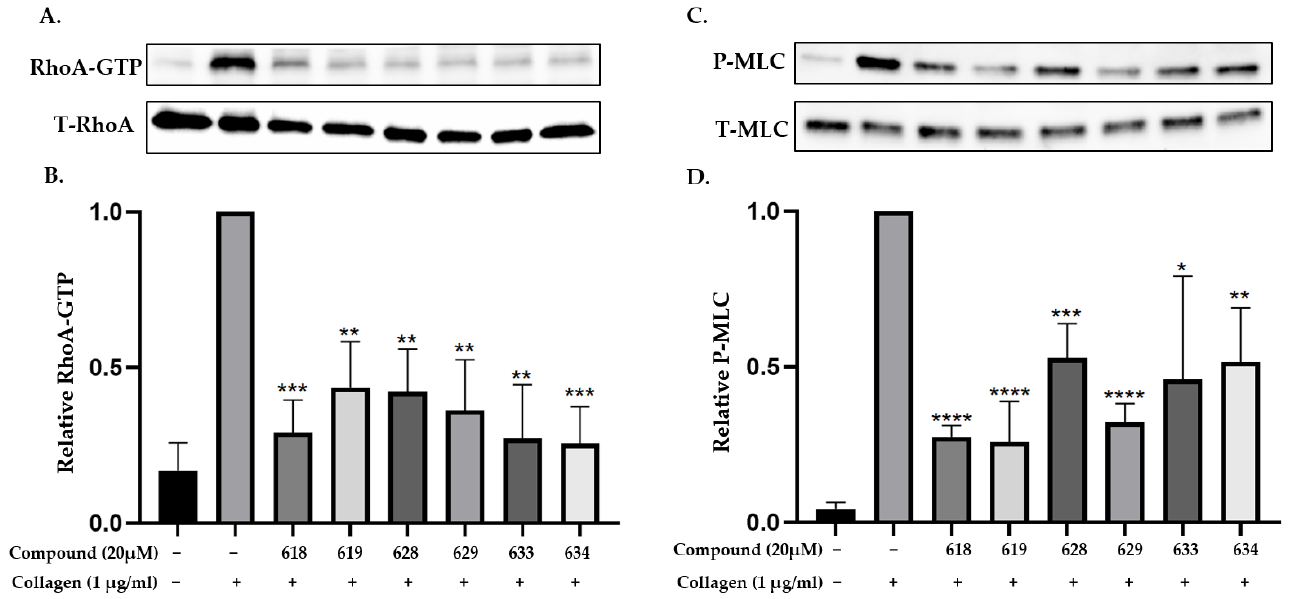
Figure 2. Active Rhosin-related compounds inhibit the activation of RhoA and phosphorylation of the myosin light chain. ( A , B ) Washed human platelets were incubated with collagen (1 µg/mL) for 4 min, and the levels of RhoA-GTP formation were quantified with a GST-Rhotekin effector pull-down assay. The platelets were pre-incubated with 20 µM UC-177618, UC-177619, UC-177628, UC-177629, UC-177633, or UC-177633 for 2 min before being stimulated with collagen. The addition of ice-cold lysis buffer terminated the reaction. The top 6 active Rhosin-related compounds inhibited RhoA-GTP formation, and the total cell lysates were also blotted in parallel. Relative amounts of the GTP-bound form of RhoA were quantified with densitometry measurements of total RhoA (T- RhoA) and normalized to untreated platelets. ( C , D ) The addition of 20 µM of active Rhosin-related compounds to washed human platelets 2 min before stimulation with collagen blocked the phos- phorylation of the myosin light chain (p-MLC). The reactions were terminated after 4 min by adding 4x Laemmli sample buffer. The samples were processed for Western blotting and probed for MLC and p-MLC, and phosphorylation was quantified by measuring the densitometry of total MLC (T- MLC). The differences between DMSO- and Rhosin-related compounds were analyzed with t -test, and the results are shown as means ± SDs of three independent experiments. (* p < 0.05, ** p < 0.01, *** p < 0.001, and **** p < 0.0001.)